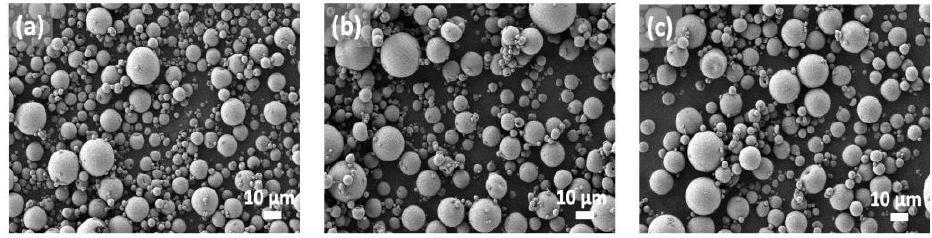
Figure A1. SEM images of SD microparticles synthesized without templating colloids using Bh as Al 2 O 3 precursor and the same spray drying parameters. ( a ) 10 wt.% SD slurry; ( b ) 15 wt.% SD slurry; ( c ) 20 wt.% SD slurry.